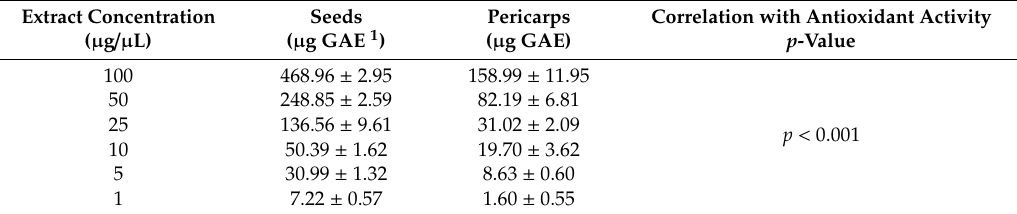
Table 3. Determination of total phenols by the Folin–Ciocalteau method in extracted of seeds and pericarps of EMB. Data are expressed as mean ± SD of 3 independent experiments. Each result showed a positive correlation ( p < 0.001) with DPPH and ABTS